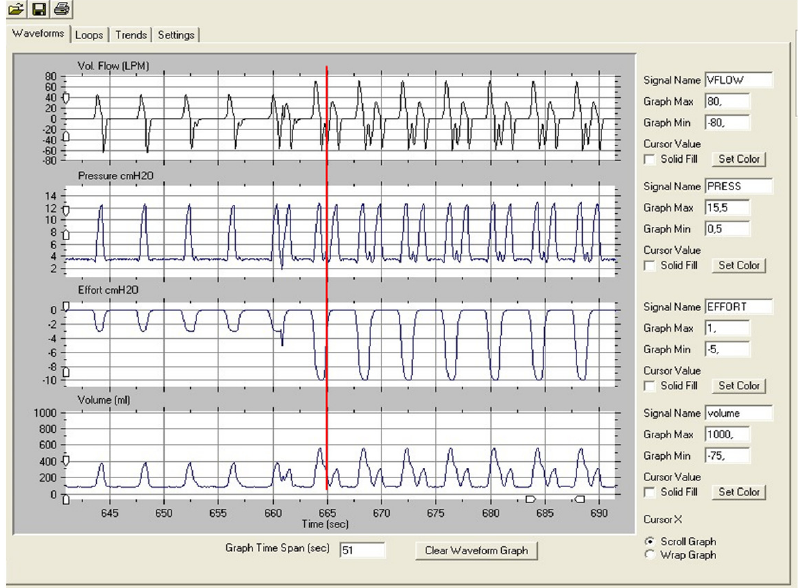
Figure 2. Autotriggering induced by noise in the expiratory phase of the cycle in a ventilator with electronic trigger (shape method). Observe that it cannot be considered as a double triggering because the e ff ort (red vertical line) clearly ended before the start of the second cycle.